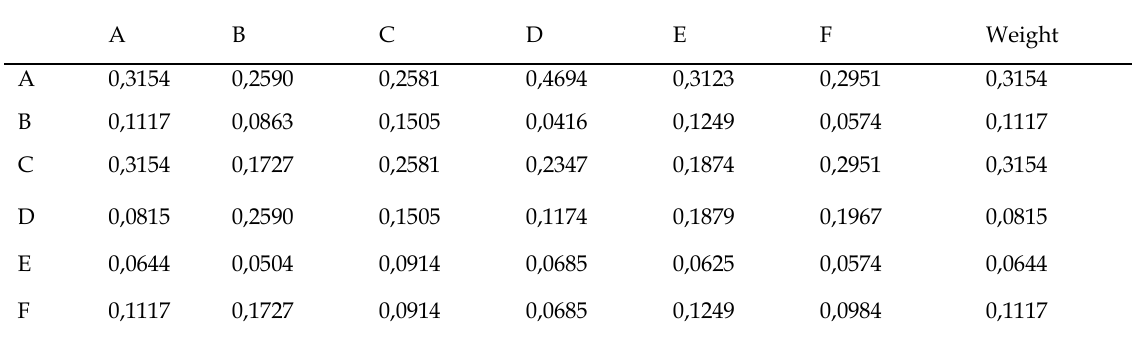
The normalized matrix